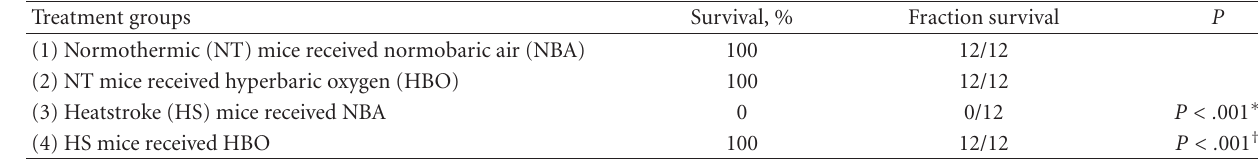
Table 1: Mean ( ± SE) of percent survival or fraction survival values for di ff erent groups of mice. Treatment groups